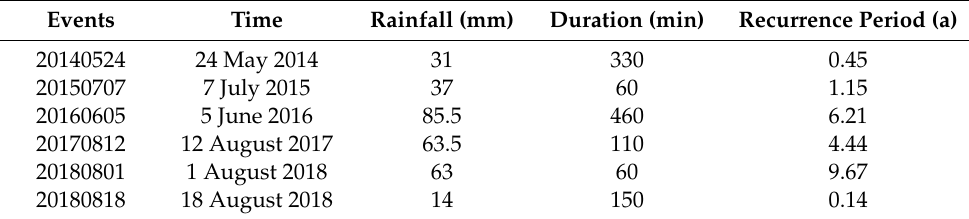
Table 5. Rainfall